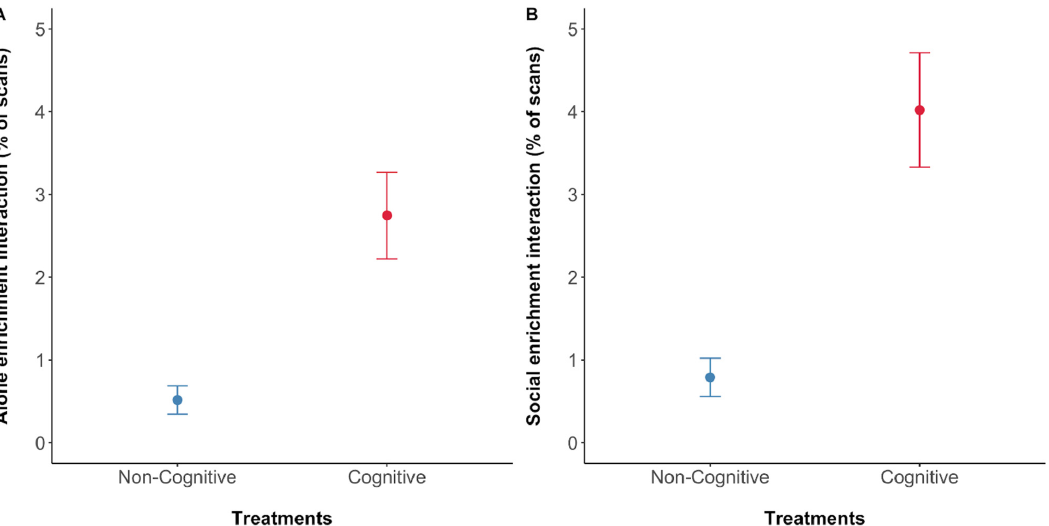
Figure 6. Dolphin’s enrichment interaction: ( A ) percentage of scans for individual interaction with the enrichment; ( B ) percentage of scans for group interaction with the enrichment. Percentage of scans denotes the average percentage of scans where the behaviour was performed as a proportion of the total visible scans in the focal 5 min observations. Means are represented by filled dots accompanied by standard error